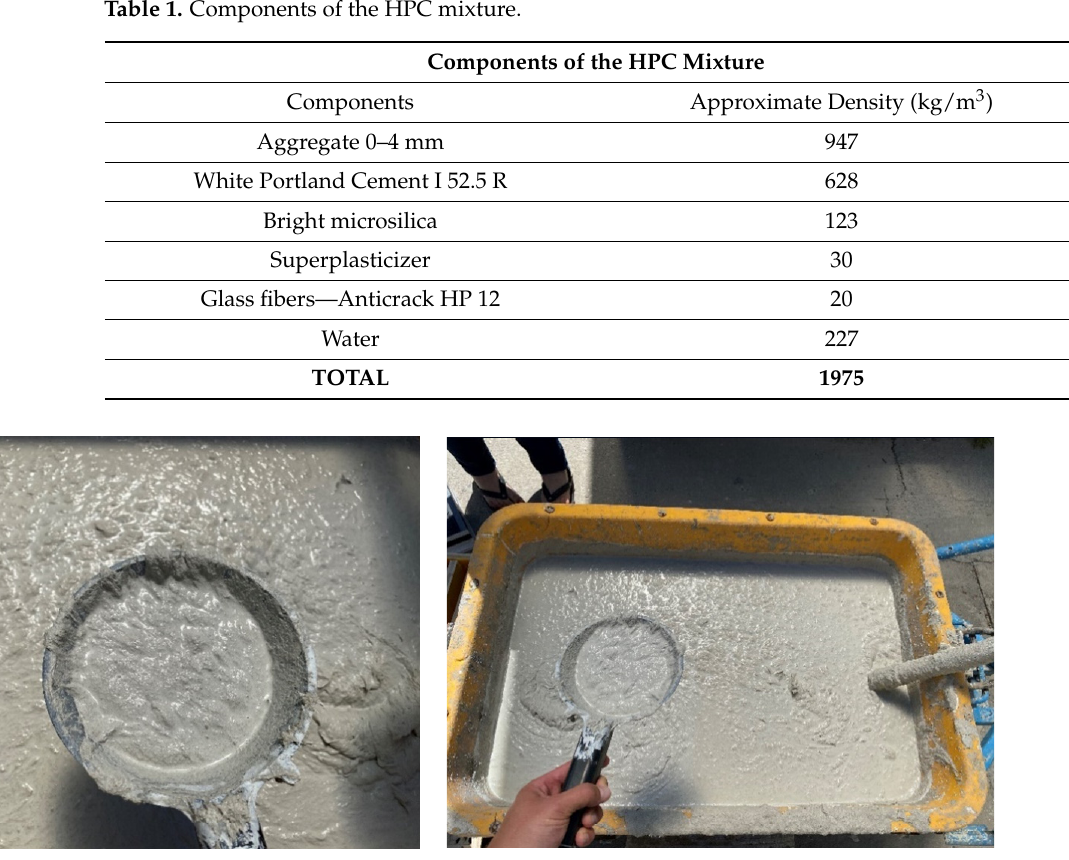
Figure 2. Concrete mixture for samples. Table 1. Components of the HPC